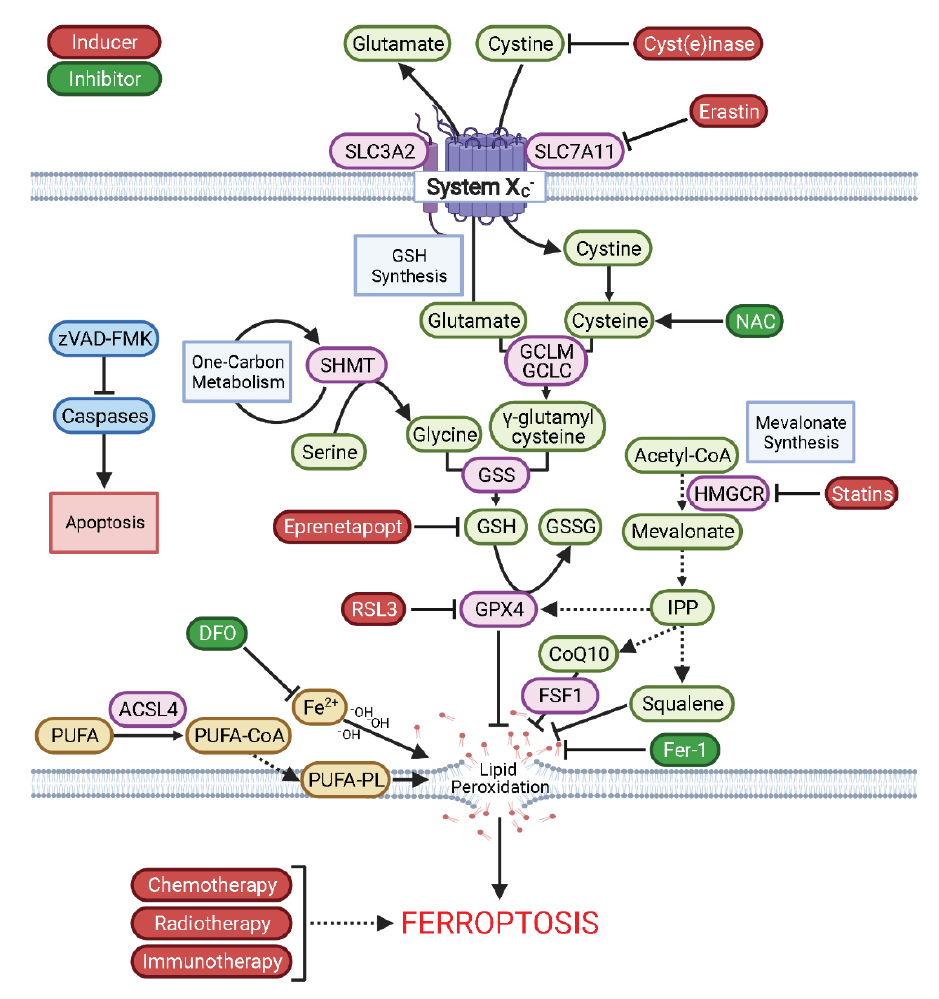
Figure 1. Mechanisms of Ferroptosis Inducers and Inhibitors. Ferroptosis is triggered following the accumulation of iron-catalysed damage to phospholipid-bound polyunsaturated fatty acids (PUFA-PLs). Glutathione peroxidase 4 (GPX4) detoxifies lipid peroxides at the expense of glutathione oxidation (GSH to GSSG). GSH is a tripeptide containing cysteine, glutamate, and glycine and is synthesised through a stepwise pathway catalysed by a glutamate–cysteine ligase catalytic subunit (GCLC), glutamate–cysteine ligase modifier subunit (GCLM), and glutathione synthetase (GSS). Cystine imported in exchange for glutamate by system x c − (encoded by SLC7A11 ) provides the main source of cysteine for GSH synthesis. Glycine for GSH synthesis can be sourced from serine catabolism by serine hydroxymethyltransferase (SHMT). Acyl-CoA synthetase long-chain family member 4 (ACSL4) acylates PUFAs, which are incorporated into plasma membranes and are vulnerable to peroxidation. Ferroptosis can be triggered by the GSH depletion (e.g., Cyst(e)inase, Erastin, Eprenetapopt) or direct inhibition of GPX4 (e.g., RSL3). Downstream products of the mevalonate pathway suppress ferroptosis, including isopentenyl pyrophosphate (IPP), which is utilised for selenoprotein synthesis (e.g., GPX4), coenzyme-Q10 (CoQ10) synthesis, which is a co-factor of ferroptosis suppressor protein 1 (FSP1, encoded by AIFM2 ), and squalene synthesis, which is a lipophilic antioxidant. Inhibiting hydroxymethylglutaryl-coenzyme A reductase (HMGCR) with statins amplifies the activity of ferroptosis inducers. Supplementation of exogenous antioxidants (e.g., NAC, N-acetyl-cysteine) to simulate GSH synthesis, lipophilic antioxidants (e.g., Ferrostatin-1, Fer-1) to detoxify lipid peroxides, and iron chelation (e.g., DFO, deferoxamine) blocks the induction of ferroptosis. Pan-caspase inhibitors fail to rescue the cell death (e.g., zVAD-FMK) induced by ferroptosis inducers. Ferroptosis induction by traditional therapies (chemotherapy, radiotherapy, and immunotherapy) contributes to their anti-cancer activity. Figure generated using BioRender.com (21 June 2021).